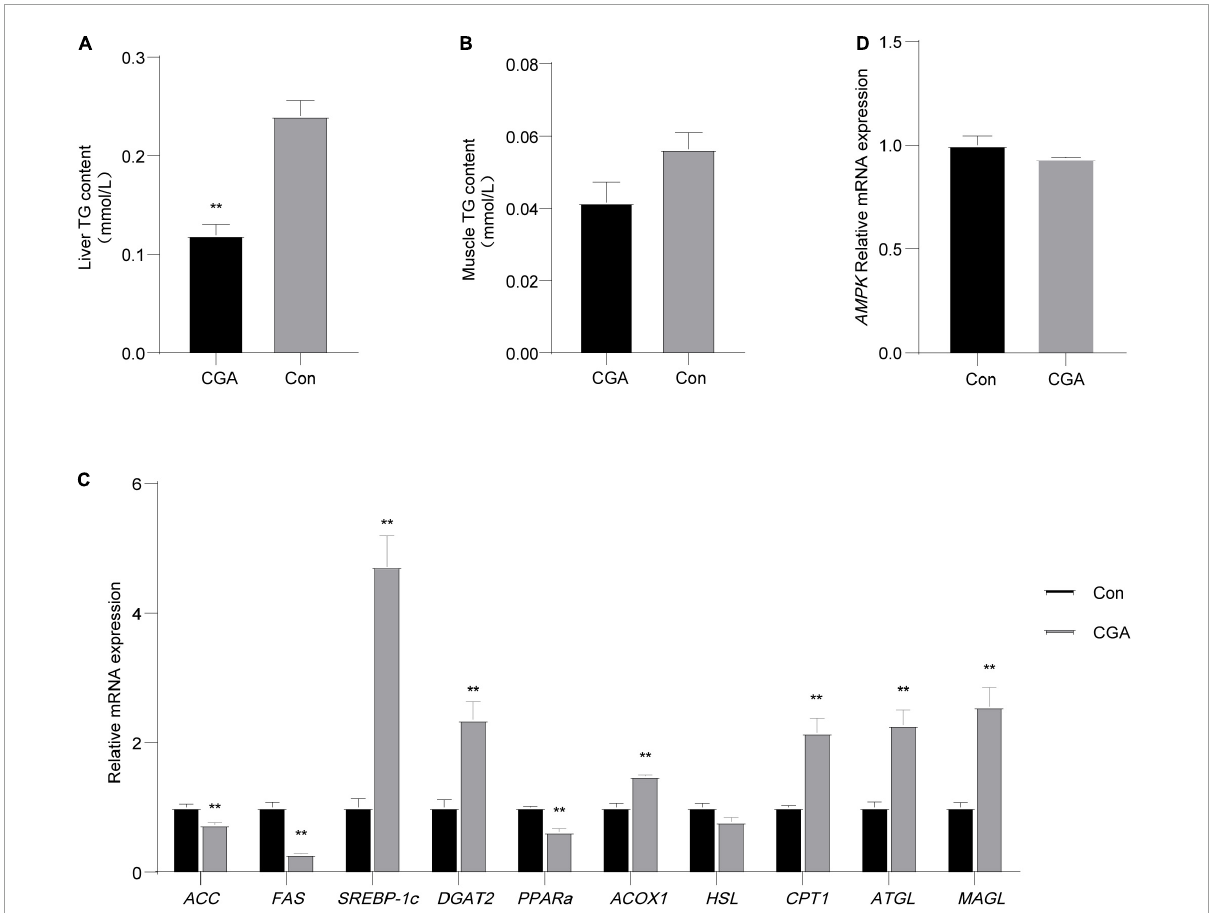
FIGURE2 Effect of chlorogenic acid (CGA) on lipid and energy metabolism of Carassius auratus . (A) Effect of CGA on triglycerides (TG) in the liver. (B) Effect of CGA on TG in muscle. (C) Expression of lipid metabolism-related genes in liver tissue. (D) Expression of energy metabolism gene AMP-activated protein kinase (AMPK) in liver tissue. **Indicates a significant difference compared with the control group ( P < 0.01). The acronym for the CGA-added group is CGA and the acronym for the control group is